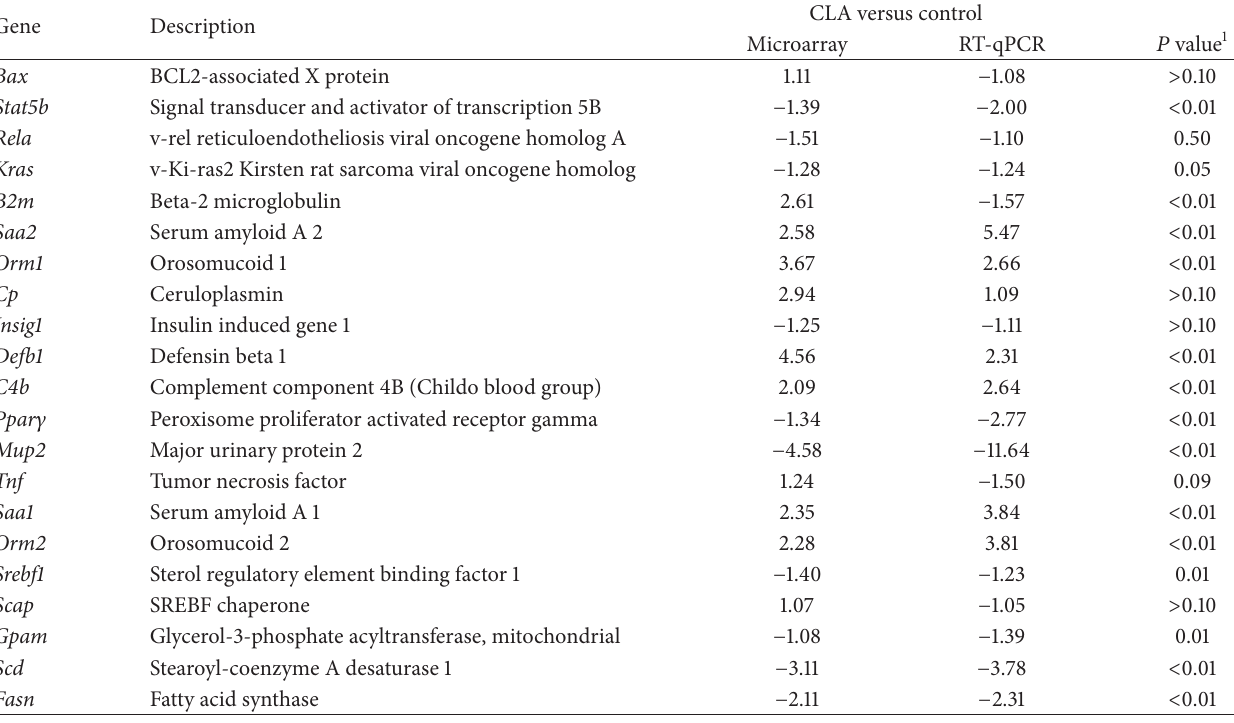
Table 5: Verification of selected genes in mammary tissue with